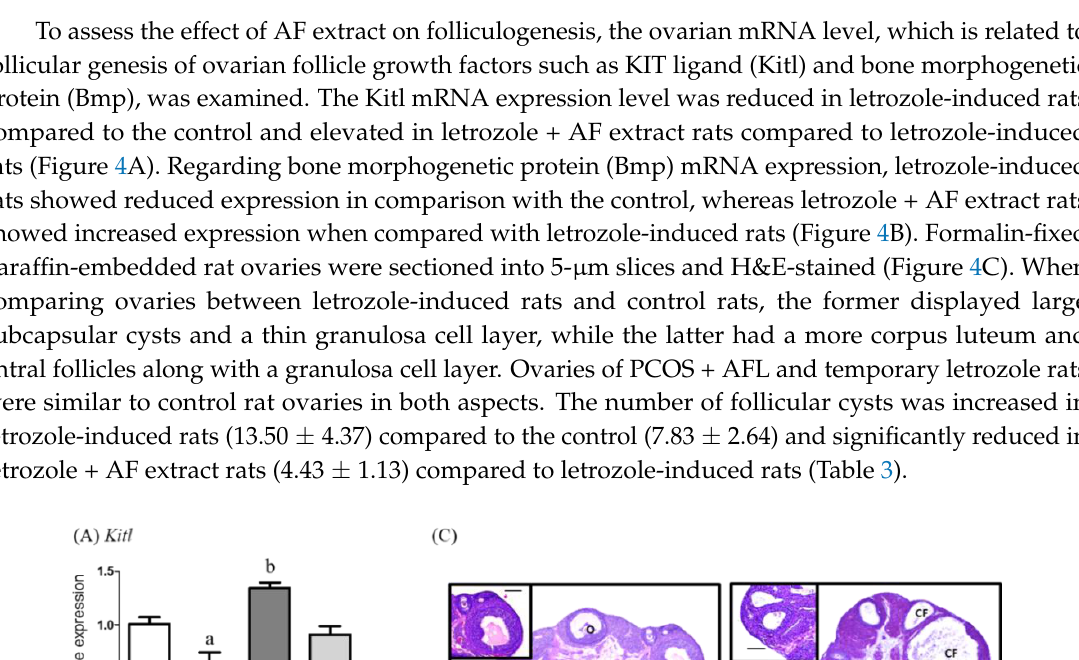
Table 3. Number of follicular cysts.